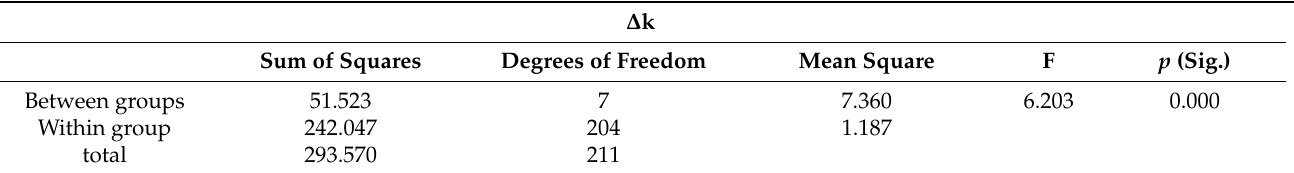
Table 6. ANOVA analysis results.